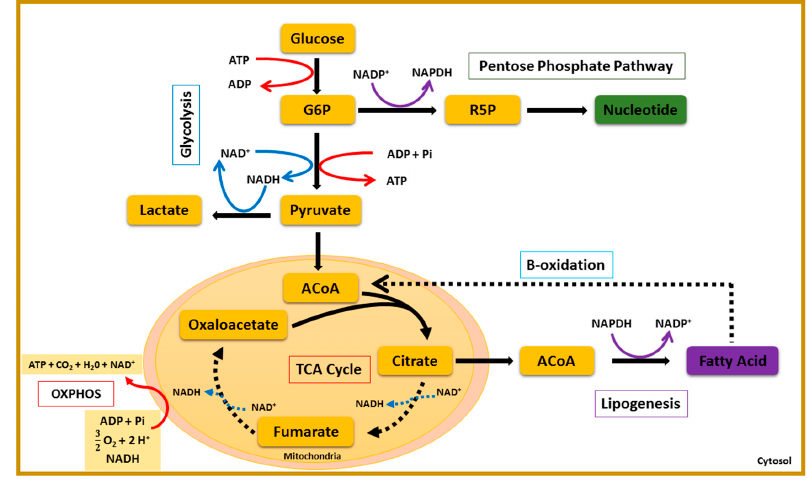
Figure 1. The central carbon metabolism (CCM). The CCM combines enzymatic reactions that convert carbon sources into biomass precursors. This figure shows the five main pathways forming the CCM: glycolysis, the pentose phosphate pathway, the tricarboxylic acid cycle (TCA), lipogenesis, and beta-oxidation. Two opposite metabolic demands are at the core of the CCM: anabolic reactions, which consist in biomass synthesis, and catabolic reactions, leading to the breakdown of macromolecules for energetic use. These two aspects of cell metabolism are managed by biochemical oscillators, including redox couples, such as nicotinamide adenine dinucleotide (NAD + /NADH) and nicotinamide adenine dinucleotide phosphate (NADP + /NADPH), and the universal energy carrier, adenine triphosphate (ATP/ADP). Transitions in CCM are reported to depend on these bio-oscillators. The NAD + /NADH ratio measures the glycolytic flux (glycolysis, PPP, and oxidative phosphorylation (OXPHOS). A high NADP + /NADPH ratio rewires glucose oxidation to the pentose phosphate pathway, whereas a low NADP + /NADPH ratio triggers lipogenesis. The ATP/(ADP + Pi) ratio senses the metabolic state of the cell and may lead to metabolic switches in the CCM.